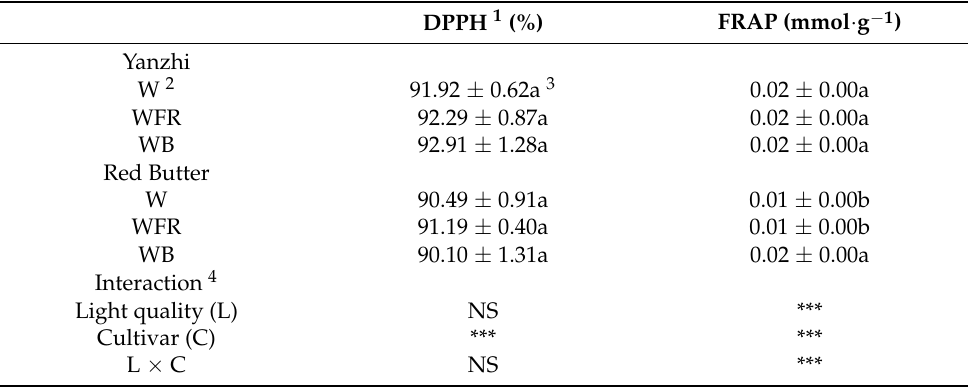
Table 5. Effects of different light quality on antioxidant activities of lettuce.